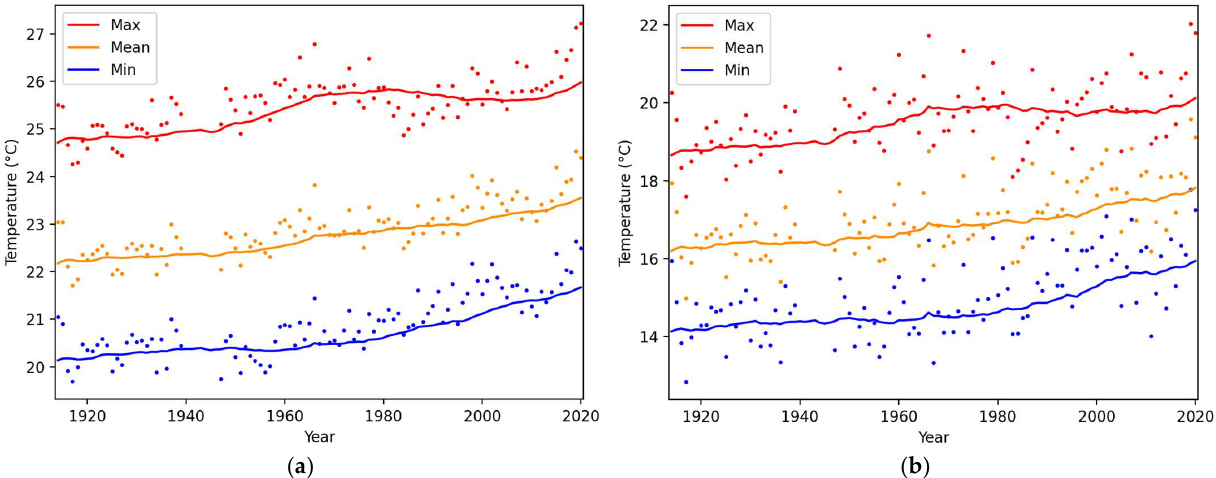
Figure 2. Long-term variations of HKO’s daily maximum, mean and minimum temperatures (ex- pressed in red, orange and blue colors, respectively) calculated by averaging over the periods of interest: ( a ) all days in a year; and ( b ) all days in cool months. The corresponding color trend lines represent the 30-year running averages of the three temperature parameters and the dots represent the value in a specific year. Based on records at HKO Headquarters from 1884 to 2020 (data not available for 1940–1946). The calendar years on the horizontal axis refer to the ending years of each running 30-year periods with the first data point plotted at 1914.